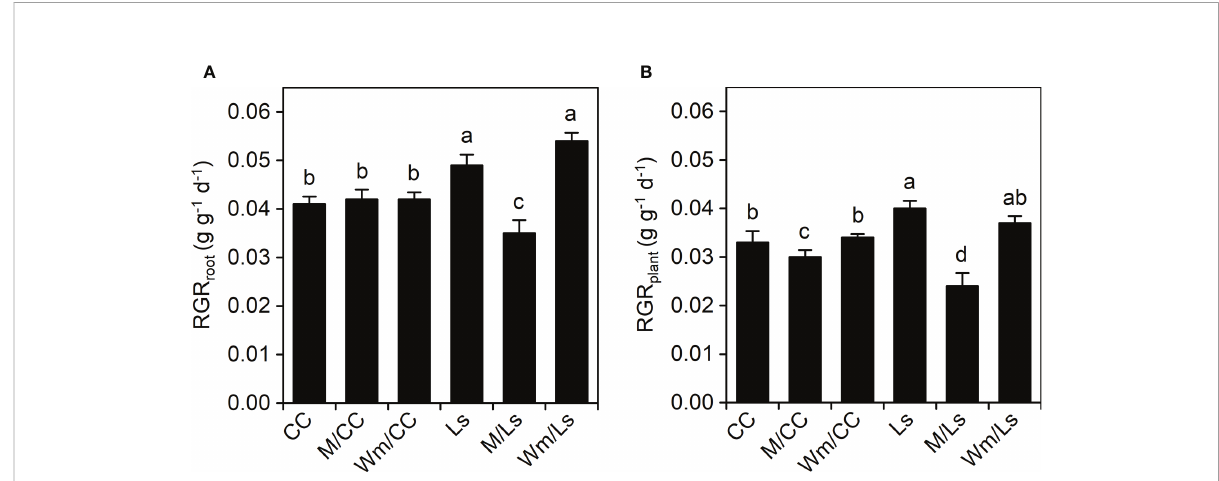
FIGURE 1 Relative growth rate of roots [RGR root , g g − 1 day − 1 ; (A) ] and entire plants [RGR plant , g g − 1 day − 1 ; (B) ] of self-grafted Cucurbita maxima × Cucurbita moschata (CC) and Lagenaria siceraria (Ls) and of respective heterograft ’ s with melon (M), and watermelon (Wm) between day 30 and 60 after grafting. Different letters indicate signi fi cant differences within RGR root and RGRplant, respectively (Tukey test, p < 0.05; mean ± SE). See Table 1 and Supplementary Table S1 for biomass at DAG 60 and DAG 30,